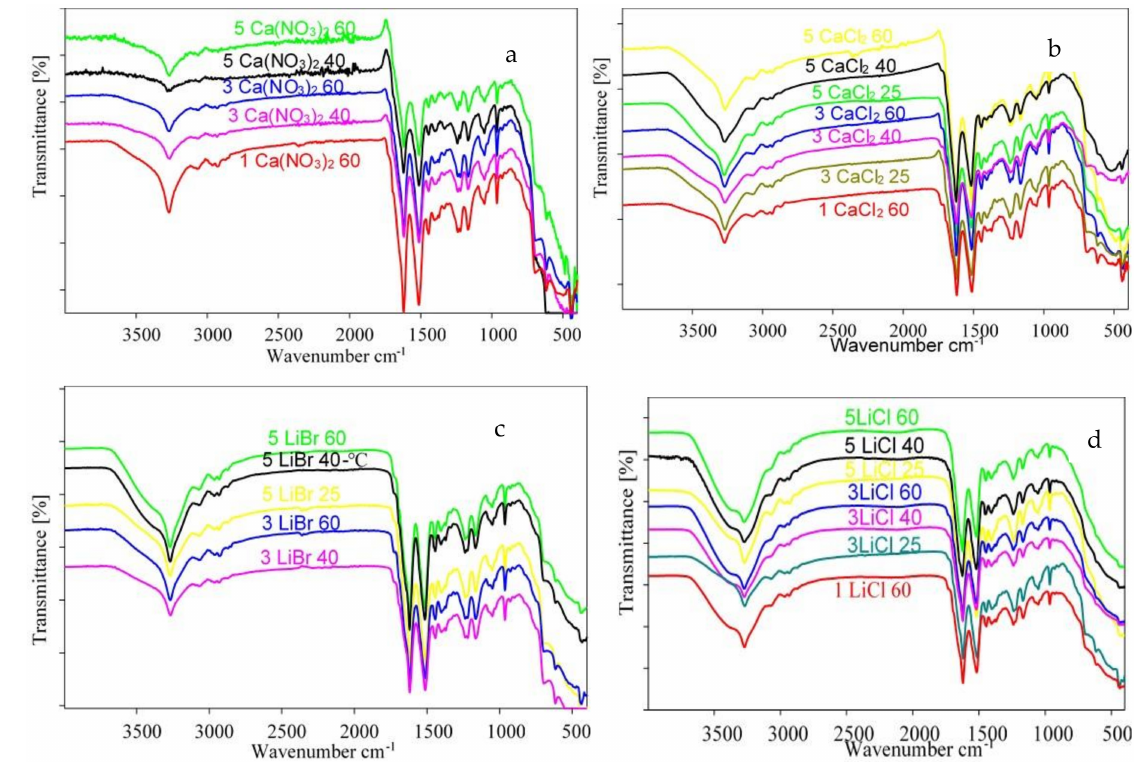
Figure 15. FTIR spectra for films produced by ( a ) Ca(NO 3 ) 2 , ( b ) CaCl 2 , ( c ) LiBr, and ( d ) LiCl solvent systems. Major changes in band positions were observed as shown on the FTIR spectra in Figure 16. The amide I and II regions of the nanofibers were characterized by bands indicat- ing α -helices at 1654 and 1541 cm − 1 , respectively. The bands around 1446 and 1372 cm − 1 shifted to 1455 and 1384 cm − 1 , respectively, which might have been due to